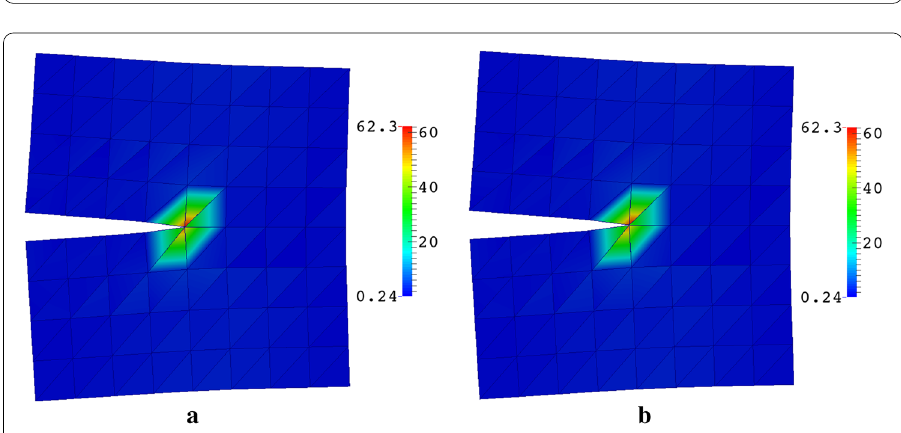
Fig. 5 TRI3 Mesh and singular enrichment adopted for 2-D edge crack problem— a FEM mesh with TRI3 elements— b nodes enriched by GFEM solver with crack tip functions. This figure presents the TRI3 discretization information for the 2-D edge crack problem used to test HNA